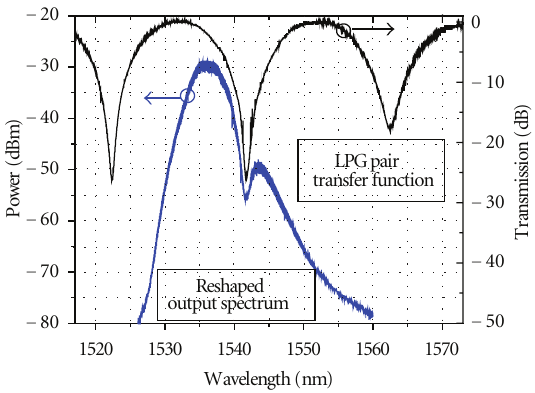
Figure 7: Transfer function of the LPG filters pair and reshaped spectrum of a 700 fs Gaussian-like pulse detuned < 4nm away from the destructive interference wavelength of the LPG